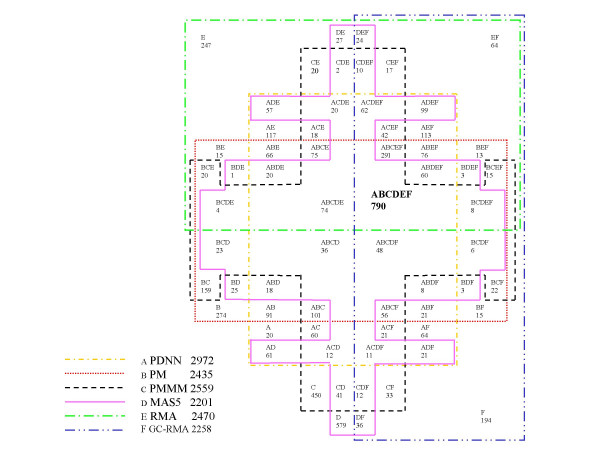
Venn diagram. Venn diagram of genes significant (Ttest p < 0.05) up or down regulated after three hours of ethylene exposure, depending of the method used to calculate gene expression. This diagram shows exactly the differences and similarities between all the methods. PDNN, MAS 5.0 (MAS, or GCOS), dChip PMMM (PMMM), dChip PM only (PM), RMA and GC-RMA were used. Only 790 genes were in common for all four algorithms. Comparable results were obtained from the low-light treatment. Areas with one letter shows genes which are unique for one method, areas with two letters shows genes which are only in common between these two methods, and so on.